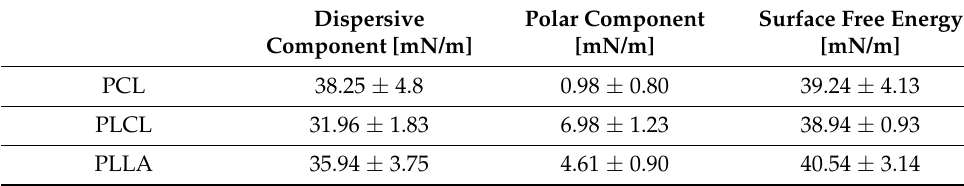
Table 2. Surface free energies and their components for control samples.